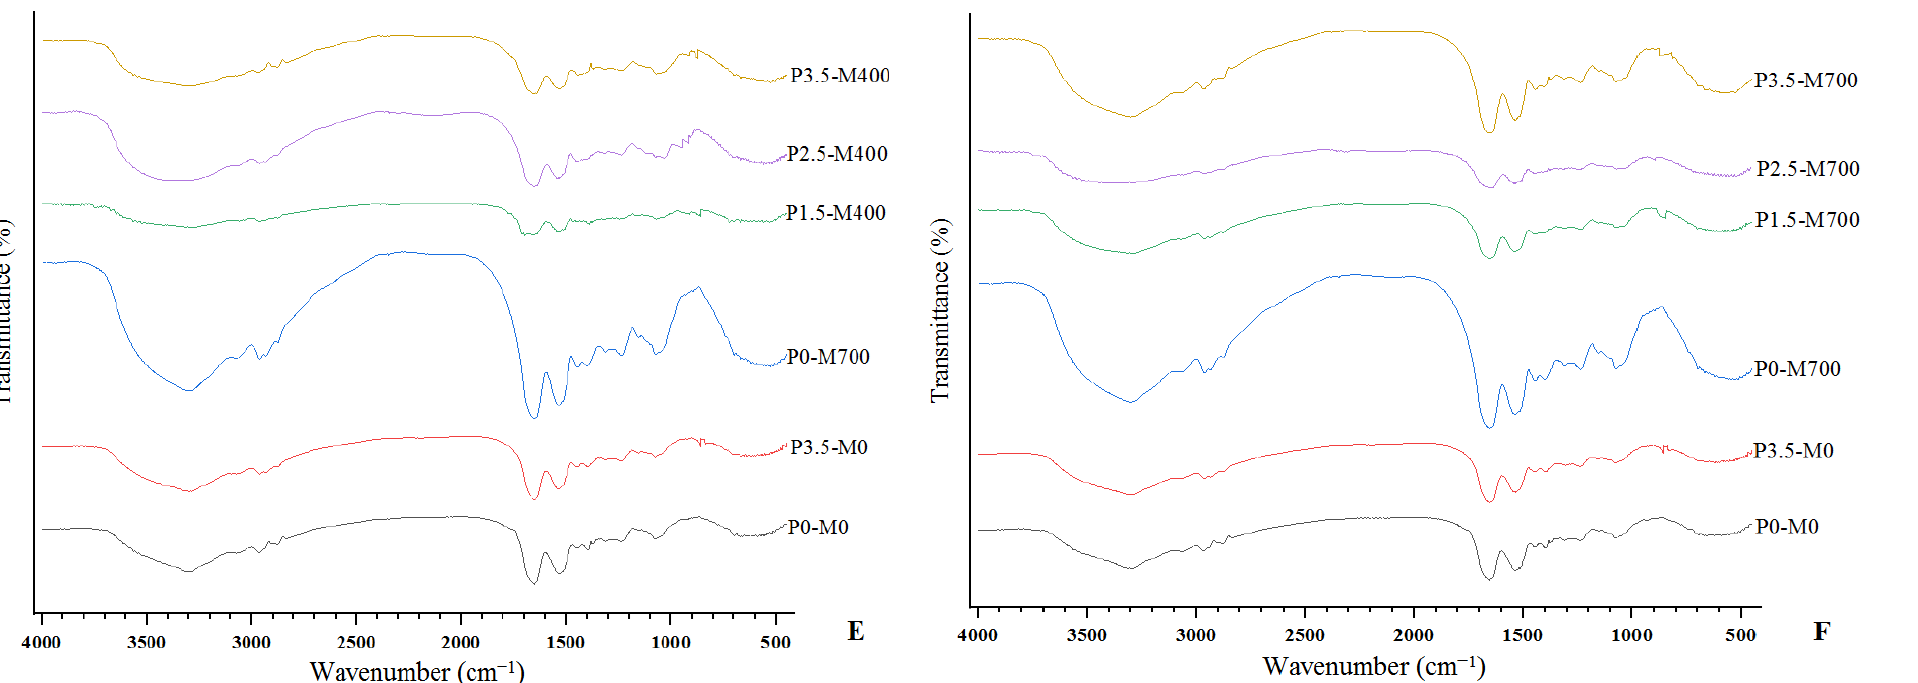
Figure 9. Fourier transform infrared spectroscopy (FTIR) of egg white powder treated with different phosphorylation (%) and microwave powers (W) ( A – C ) compare the effect of different microwave powers on 1.5, 2.5, and 3.5% phosphorylation, respectively. ( D – F ) compare the effects of different percentages of phosphorylation in microwave powers of 200, 400 and 700 watts, respectively.